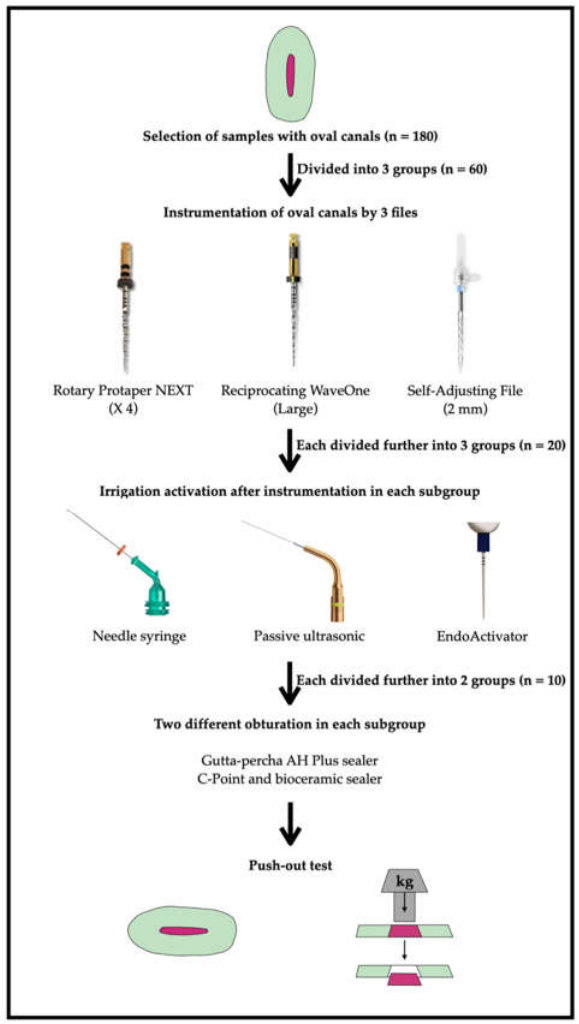
Figure 1. Flowchart of the experimental design.